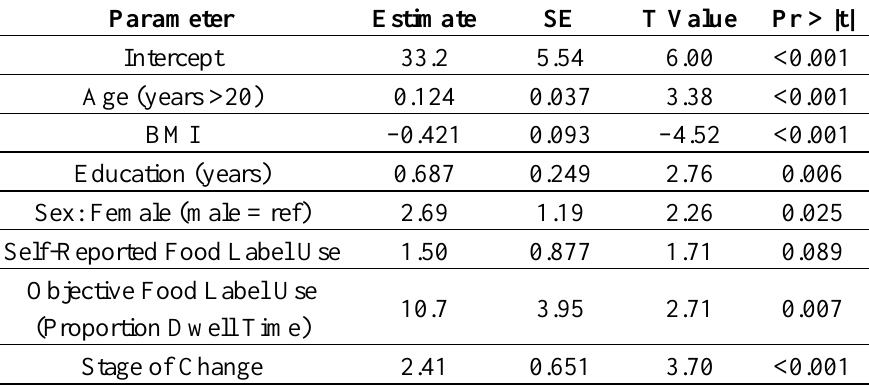
Table 3. Covariates of the Healthy Eating Index, Linear Regression Results Adding Stage of